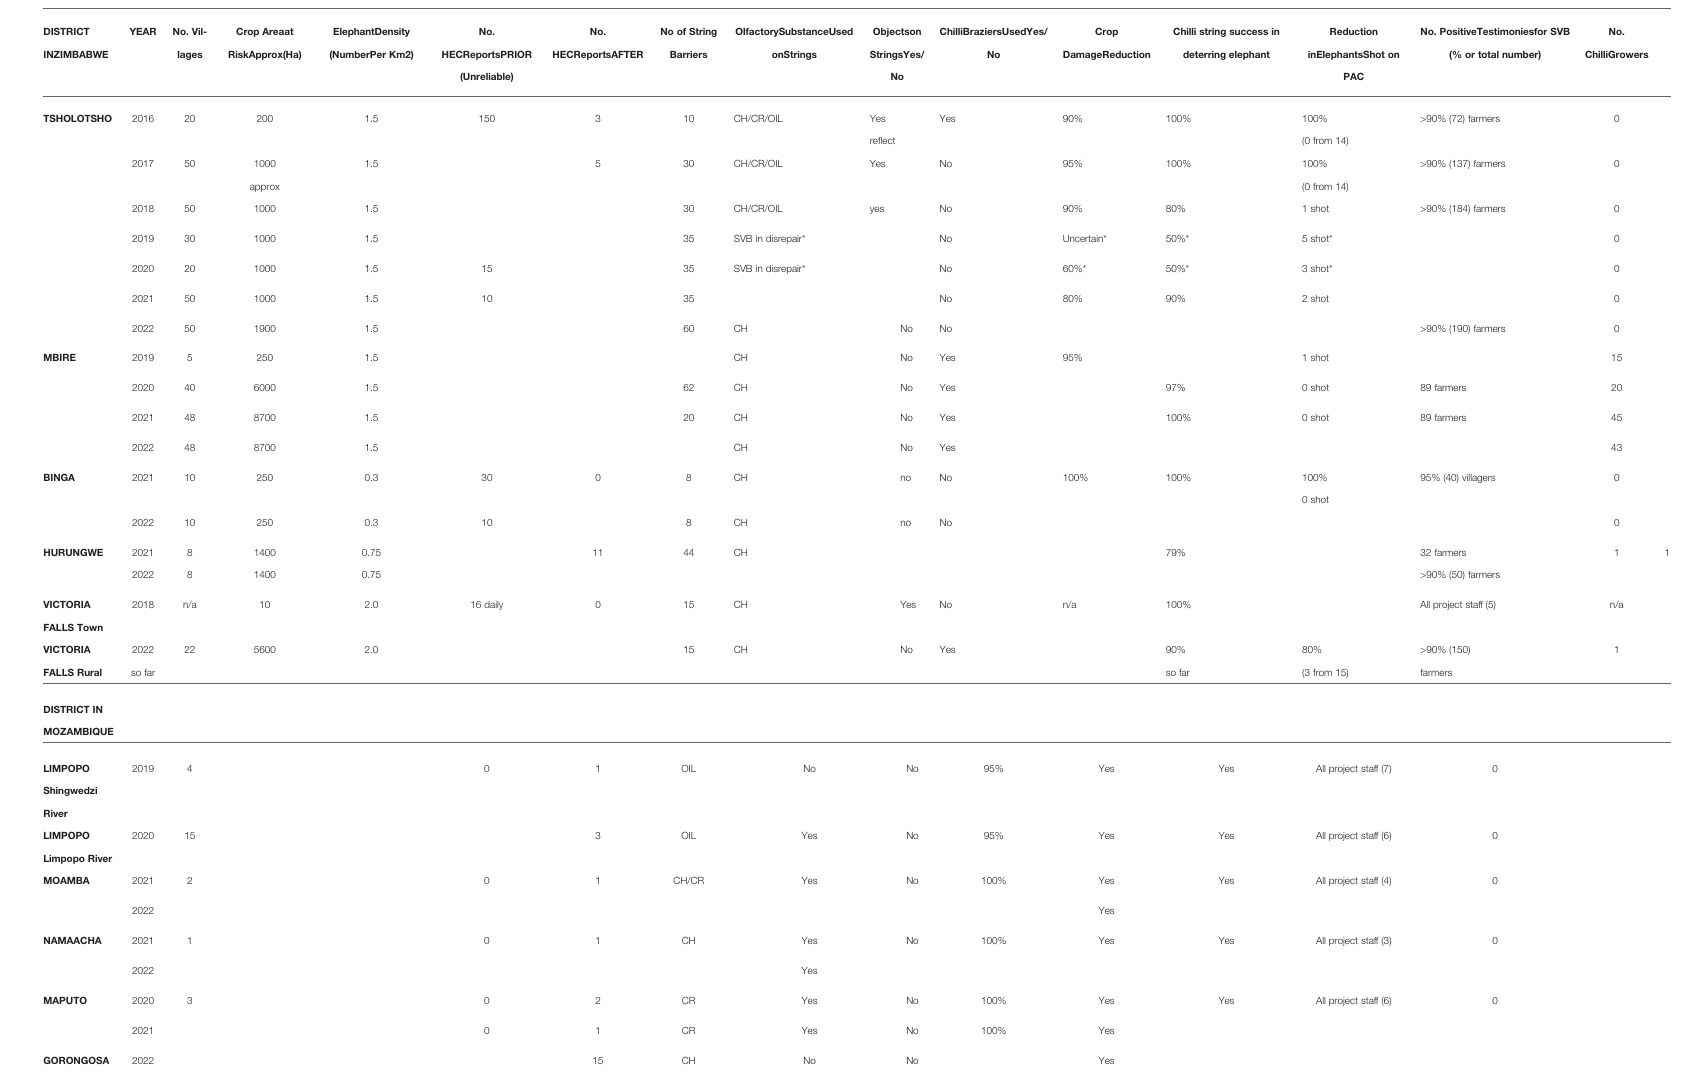
TABLE 2 | Details of the effectiveness of virtual fence study sites in Zimbabwe and Mozambique. DISTRICT YEAR No.Vil- INZIMBABWE